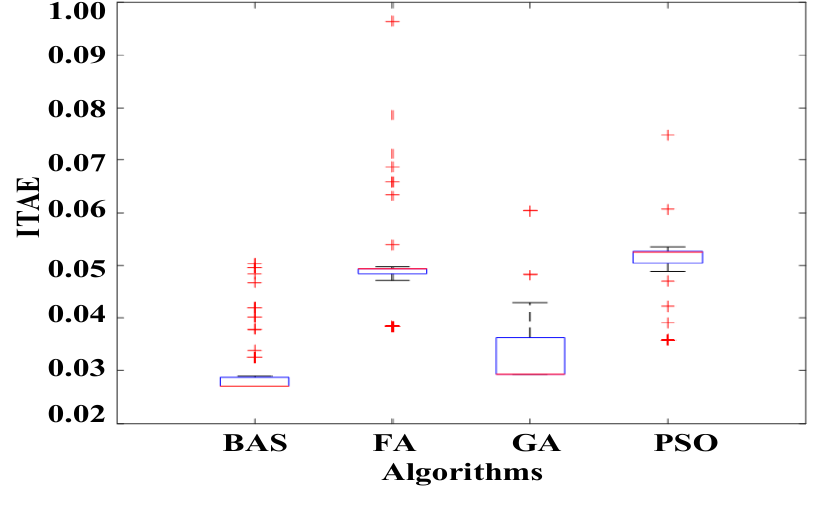
Figure 6. Boxplot of ITAE.